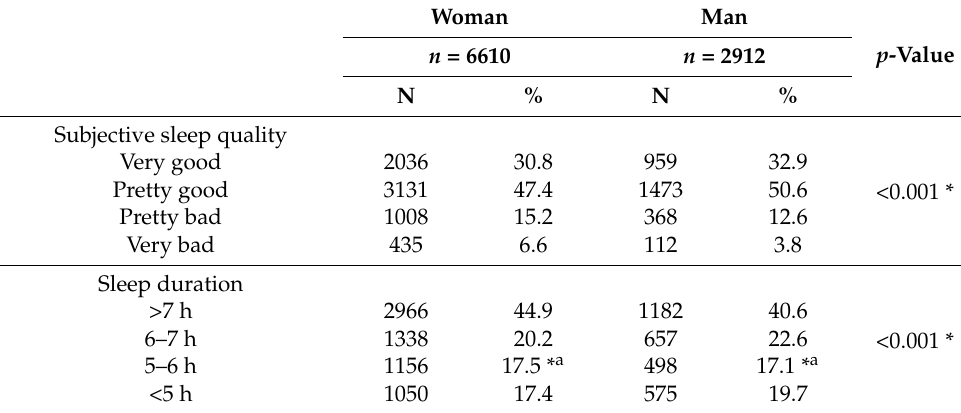
Table 5. Sleep quality in the study population by